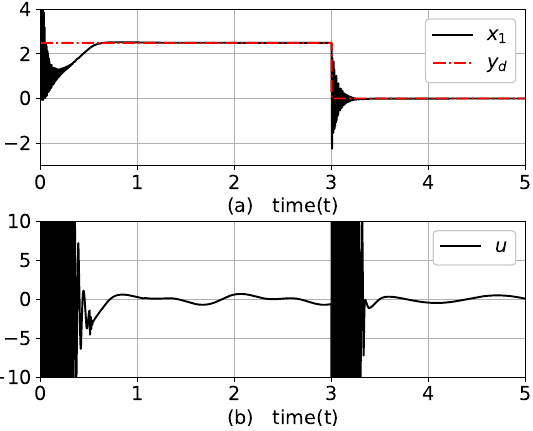
Figure 22. For the proposed HOSD: ( a ) y , y d , and ( b ) u .